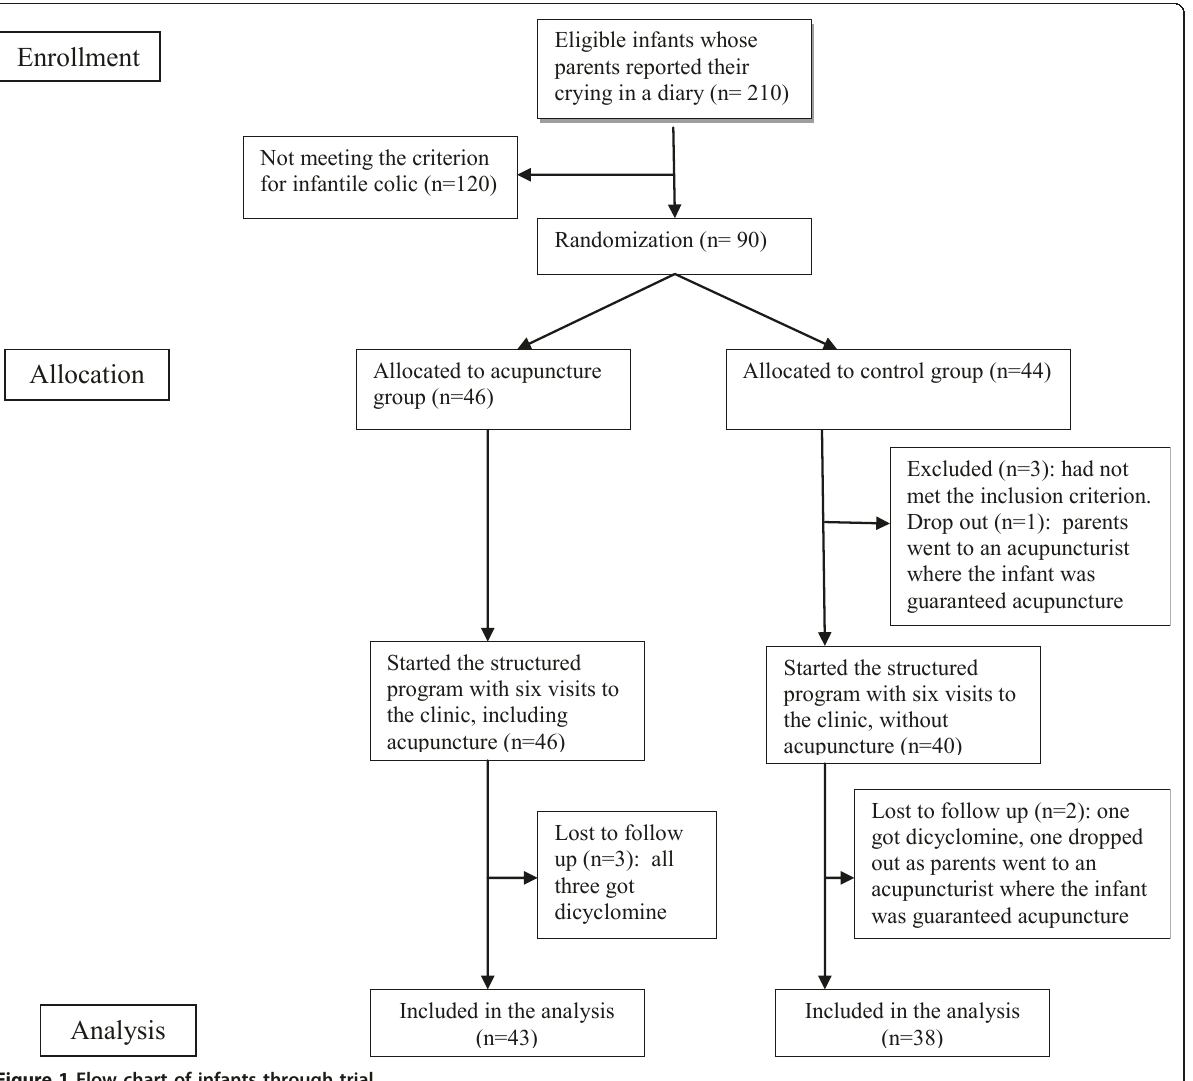
Figure 1 Flow chart of infants through trial